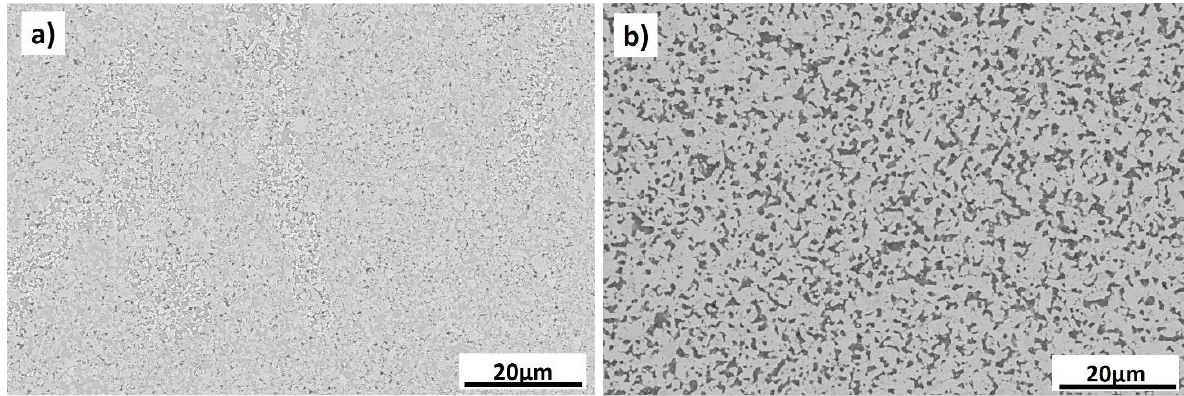
Figure 7. SEM micrographs of the consolidated WC-Co-TaC-NbC. ( a ) 0 wt% Y 2 O 3 , ( b ) 10 wt% Y 2 O 3 .